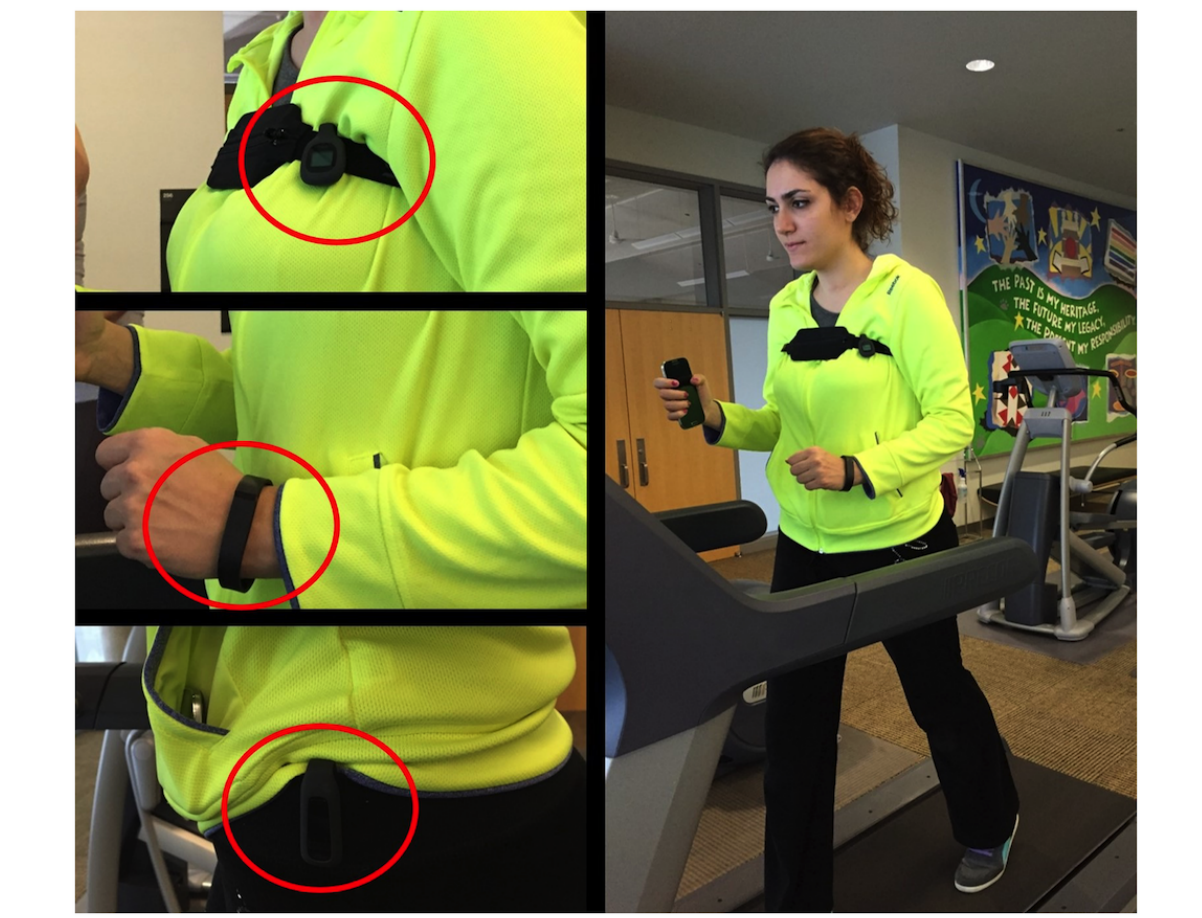
Figure 1. A participant wearing 3 trackers on the wrist, chest, and pants pocket while walking on a